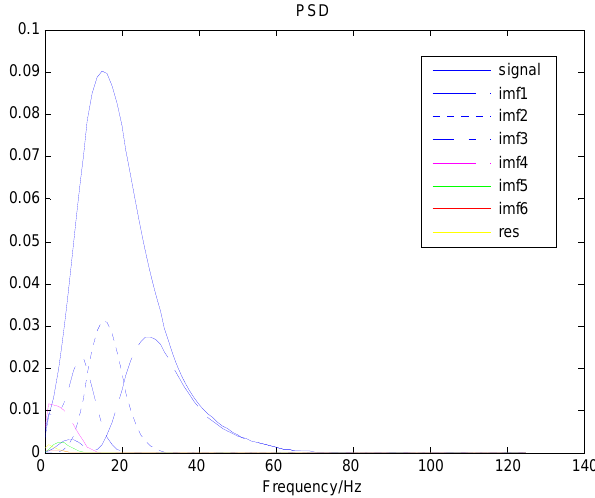
Figure 13. Power spectrum of IMF components for record 302 m.